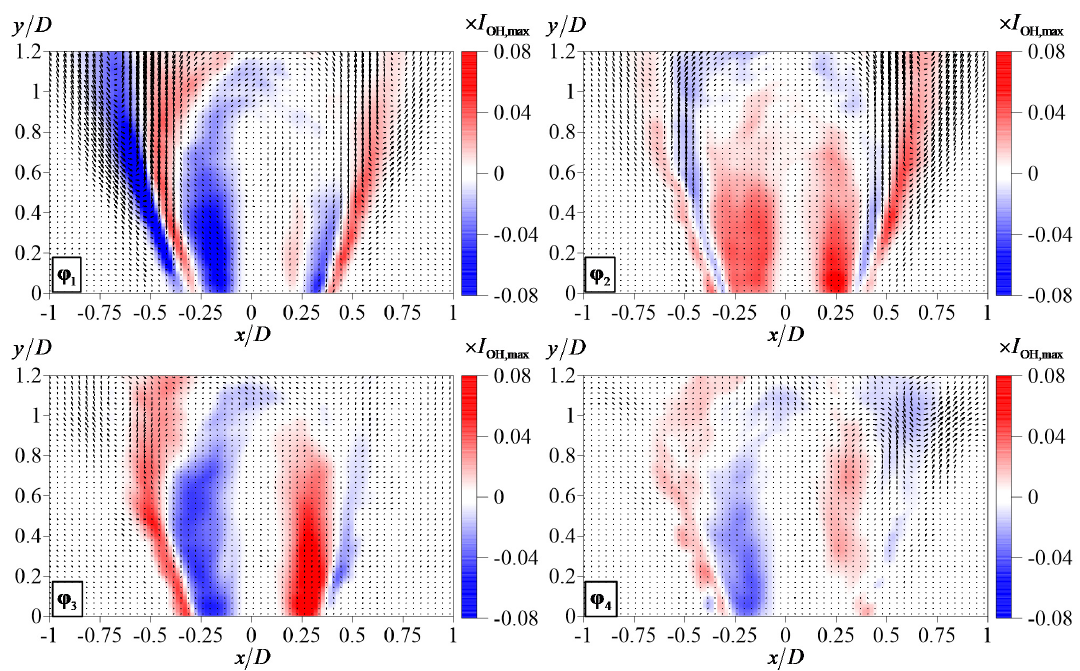
Figure 9. First four POD modes with phase-averaged OH PLIF intensity for syngas flame at normal conditions.